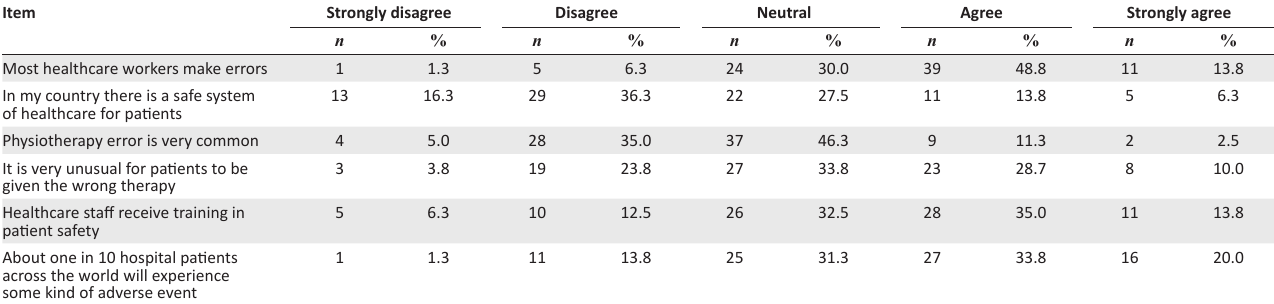
TABLE 1: Safety of the healthcare system ( n =